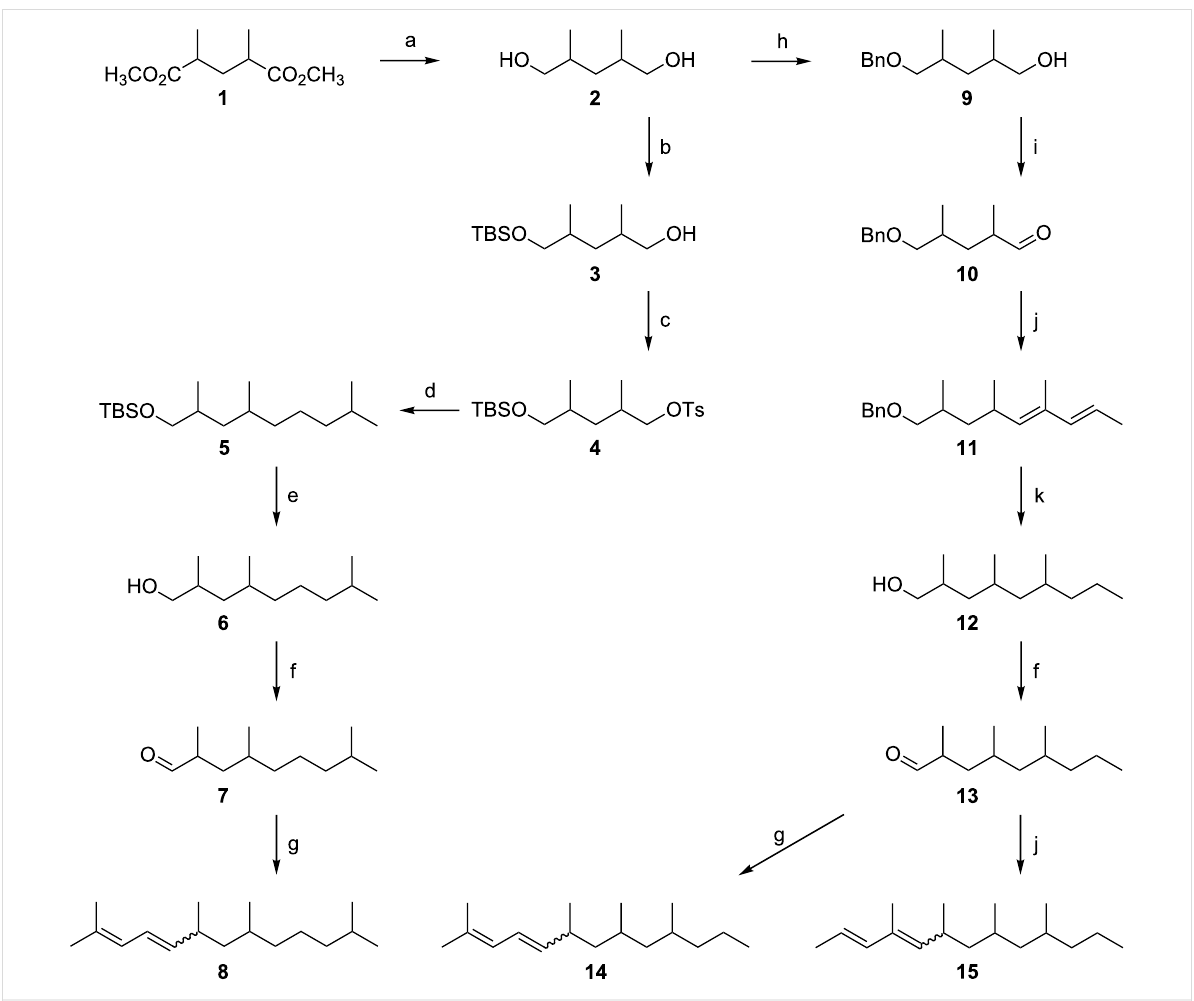
Figure 2: Synthesis of tetramethyltrideca-2,4-dienes 8 , 14 and 15 . Conditions: a: LiAlH 4 , Et 2 O, − 30 °C to rt, 12 h; b: 1) NaH, THF, − 20 °C to rt 1 h; 2) TBDMSCl (1 equiv), rt, 10 h; c: p -TsCl, DMAP, TEA, DCM, − 20 °C to rt, 12 h; d: (3-methylbutyl)magnesium bromide, CuI, THF, − 90 °C to rt, 16 h; e: TBAF, THF, rt, 14 h; f: PDC, MS 4 Å, DCM, − 20 °C, 90 min; g: (3-methylbut-2-en-1-yl)triphenylphosphonium bromide, n -BuLi, THF, − 40 °C to rt 16 h; h: 1) NaH, THF, − 20 °C to rt, 1 h; 2) BnBr (1 equiv), n -Bu 4 NI, 0 °C to rt, 16 h; i: PCC, MS 4 Å, DCM, − 20°C, 90 min; j: [( E )-1-methylbut-2-en-1- yl]triphenylphosphonium bromide, n -BuLi, THF, − 40 °C, 14 h; k: H 2 , 20 bar, 10% Pd/C, pentane, rt, 18